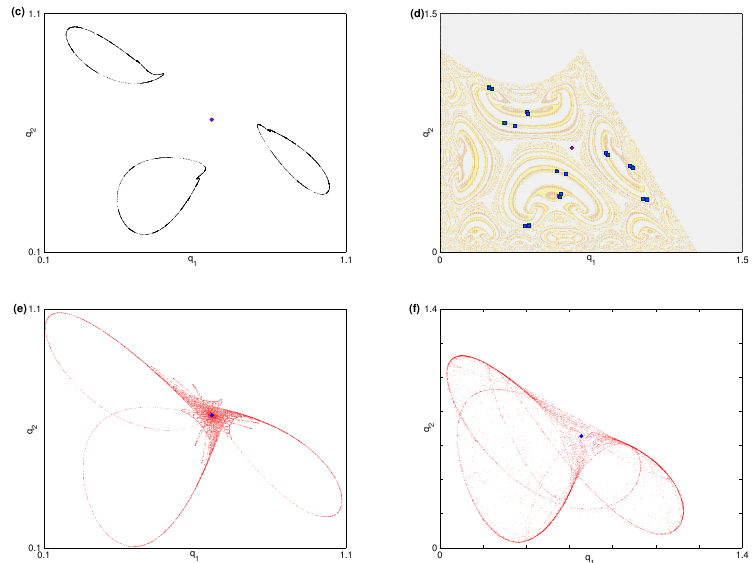
Figure 3. ( a ) The phase plane of three closed invariant curves at k = 1.49. ( b ) Basin of attraction of period-15 cycle at k = 1.516. ( c ) The phase plane of three closed chaotic areas at k = 1.525. ( d ) Basin of attraction of period-18 cycle at k = 1.5288. ( e ) The phase plane of a chaotic attractor at k = 1.558. ( f ) The phase plane of a chaotic attractor at k = 1.59. Other parameters’ values are a = 2, b = 0.9, c = 0.1.